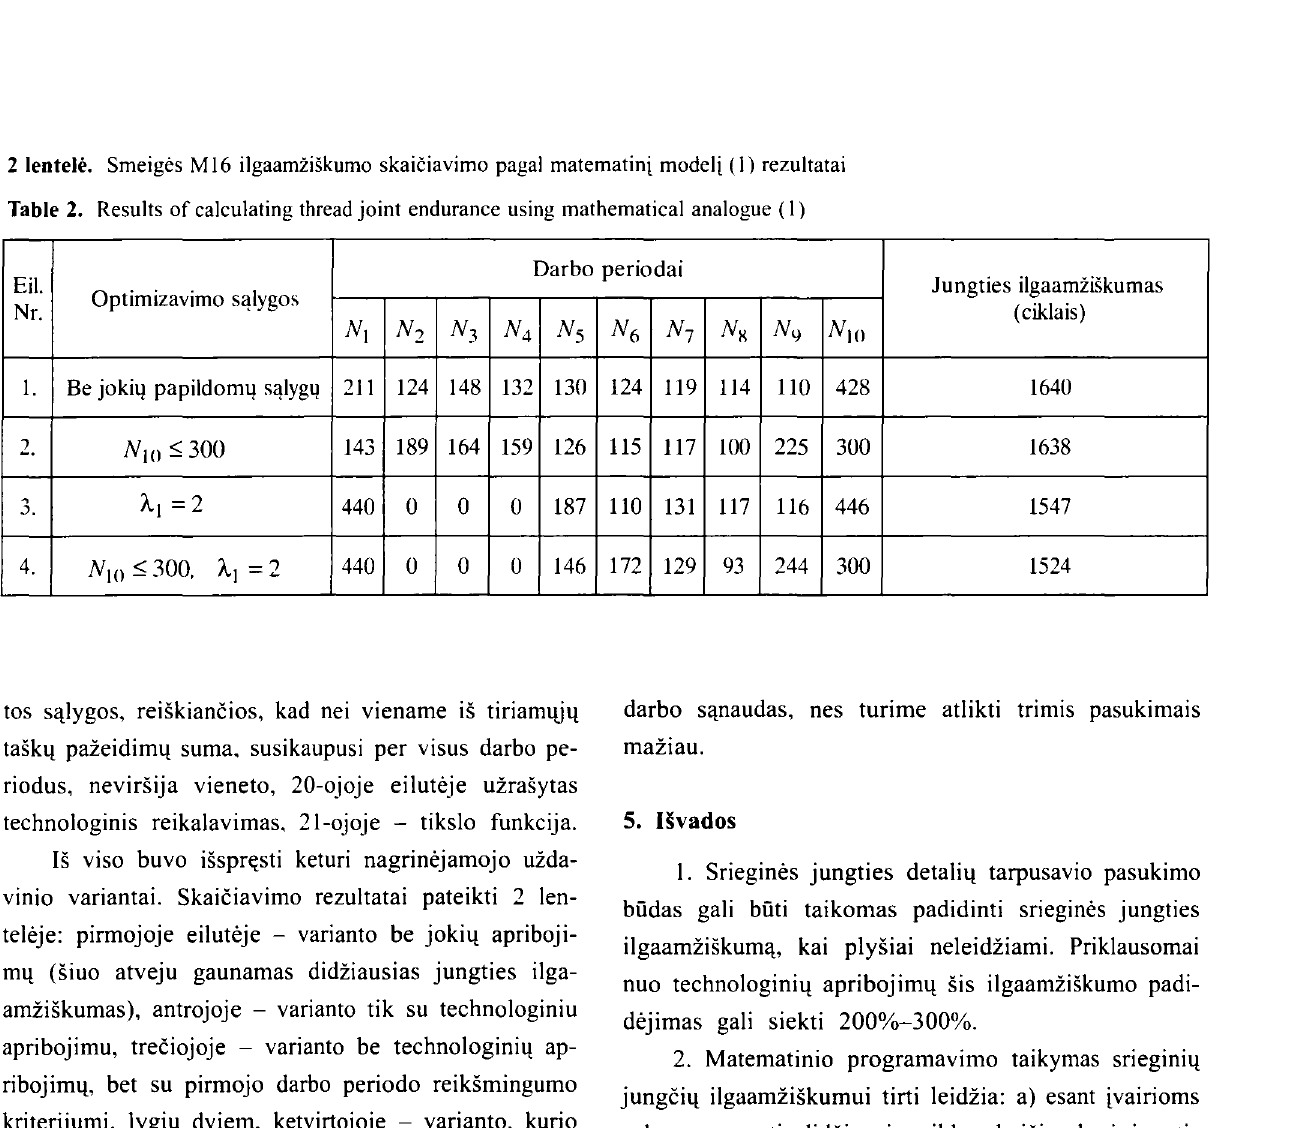
Table 2. Results of calculating thread joint endurance using mathematical analogue ( I) Eil.